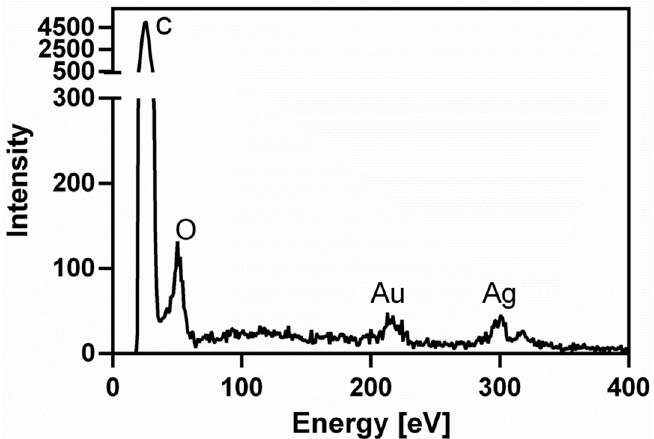
Figure 9. EDS of the 3D-printed scaffold containing PLA+2[(f-EG)+Ag].